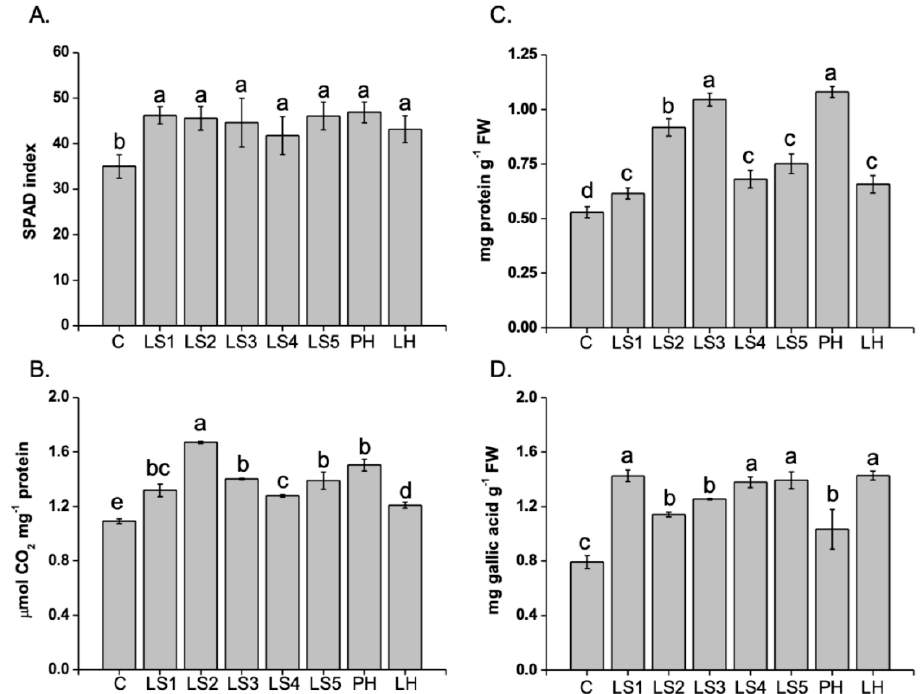
Figure 4. E ff ect of humates (Hs) on SPAD index ( A ), RuBisCO activity ( B ), protein content ( C ), and total phenolic compounds ( D ) in leaves of Z. mays L. plants. Twelve-day-old plants were supplied with Hs at 1 mg C L − 1 for two days. Di ff erent letters above bars indicate significant di ff erences at p < 0.05, according to Student–Newman–Keuls test. Data represent the means of three measurements with three plants in each ( ± SD). C = control; LH = commercial lignosulfonate-based product; PH = commercial humate extracted from leonardite; LS1-LS5 = specialty